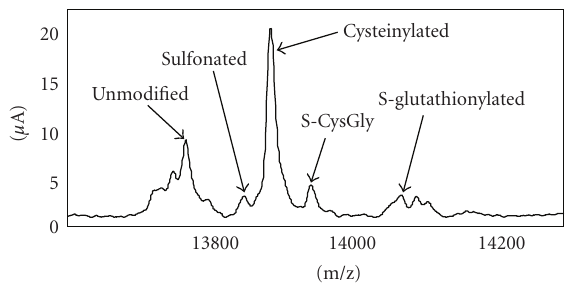
Figure 4: Modified transthyretin forms observed in ovarian cancer sample, adapted from